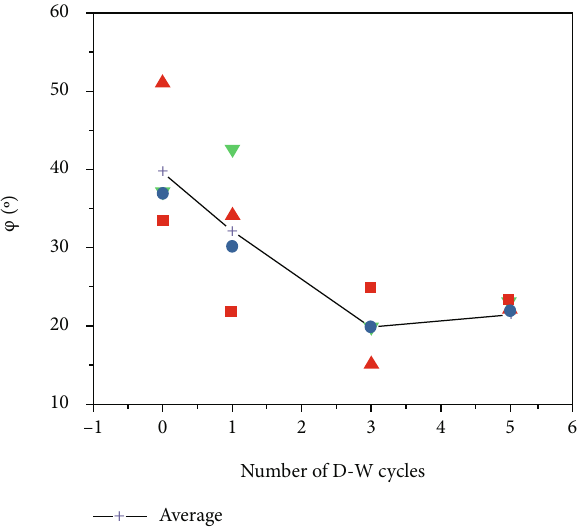
Figure 7: The relationship between the number of D-W cycles and internal friction